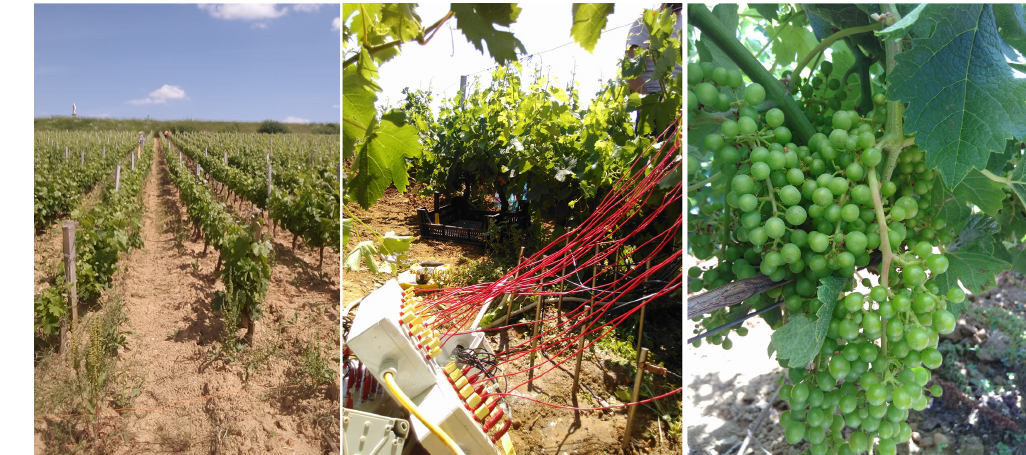
Figure 1. Picture of the field site in May 2017 (a) , wired plants investigated (b) , and grape status during the experiment in June 2017 (c)